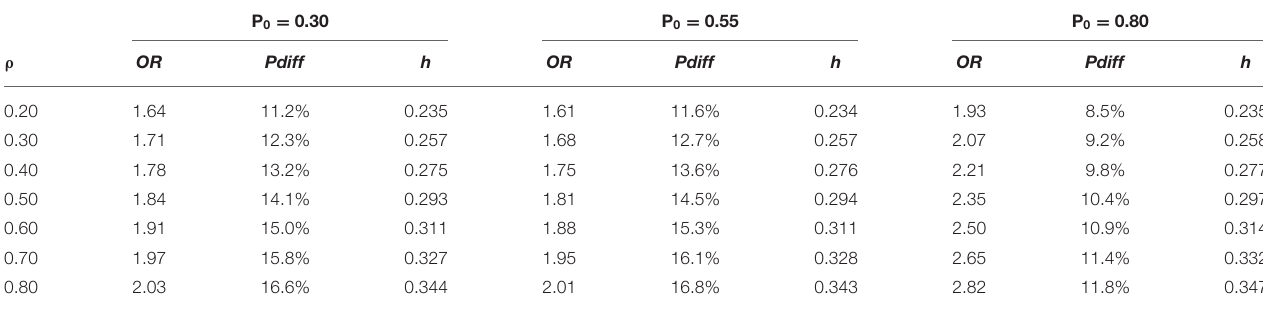
TABLE 5 | Within-subject correlations.